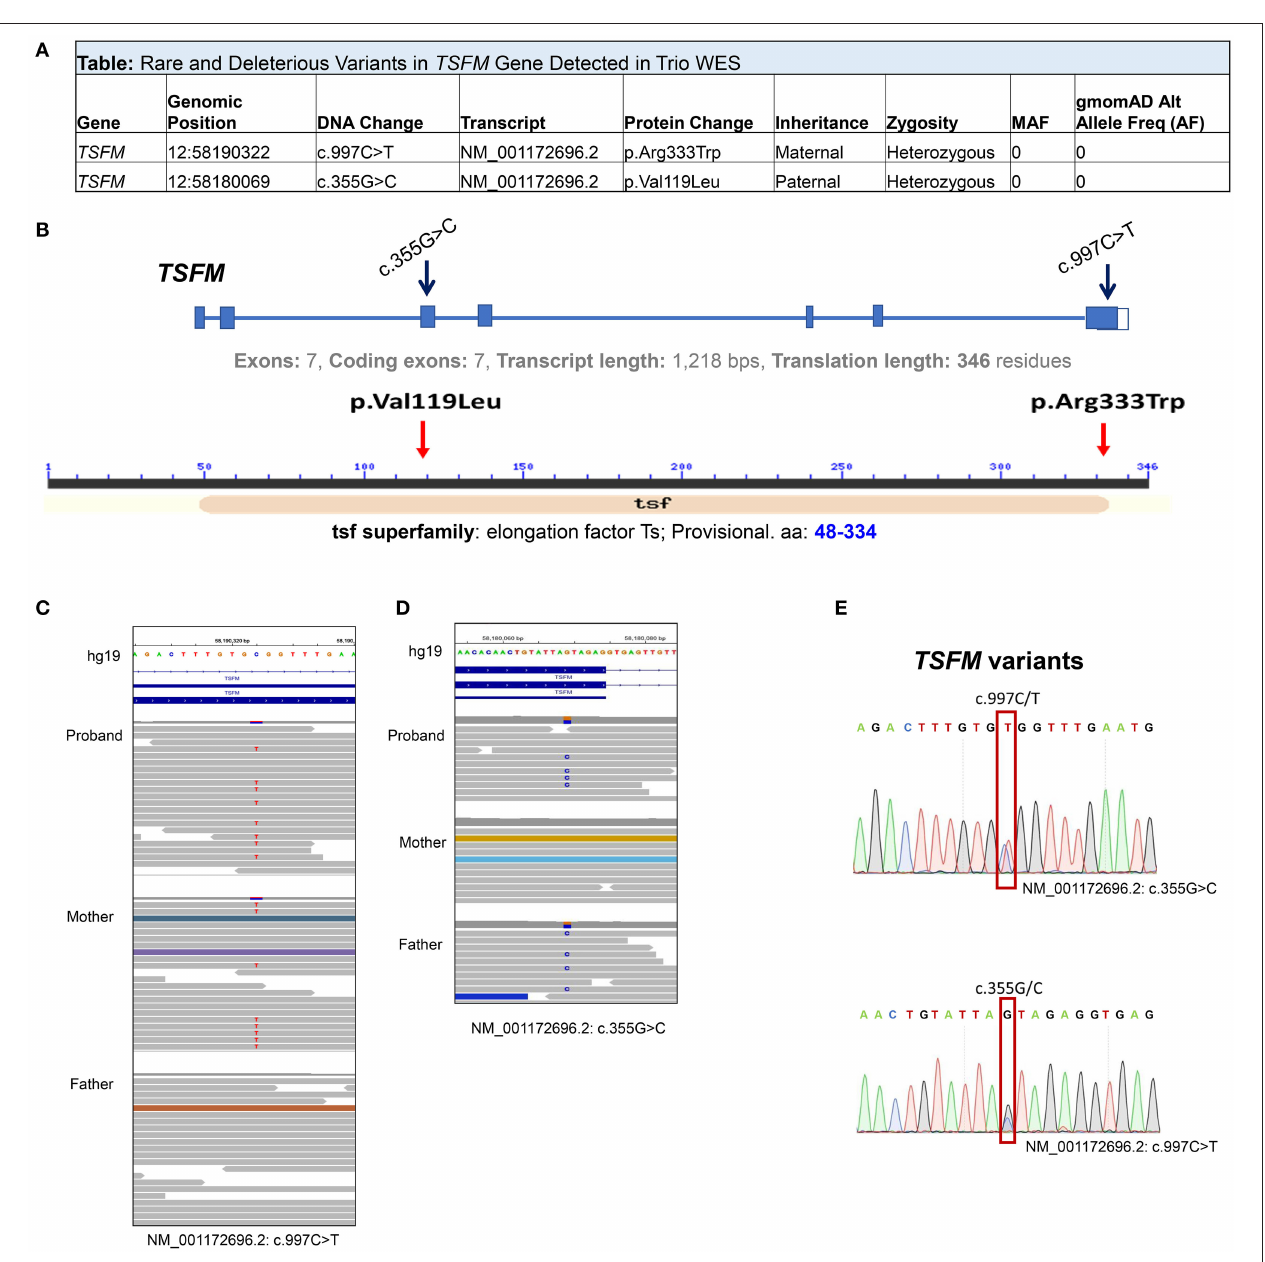
FIGURE 3 | Compound Heterozygous Variants of TSFM Revealed by Trio (Proband/Parents) Whole Exome Sequencing (WES). (A) Table summary depicts rare compound heterozygous variants in TSFM genes detected by WES. (B) Schematic representation of TSFM gene (upper) and TSFM protein (lower) and known structural motifs. Black arrows indicate exons affected by deleterious mutations. Red arrows indicate the positions of AA substitutions in TSFM protein sequence caused by TSFM variants. (C,D) Integrated genomic viewer windows depict tow heterozygous variants in TSFM in the proband genome, the maternally inherited c.997C > T (C) and the paternally inherited c.355G > C (D) . (E) Sanger sequencing confirms that both TSFM variants are in trans configuration in the proband